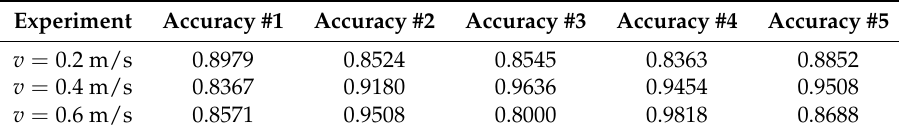
Table 3. Prediction accuracy of different speeds for different terrains.